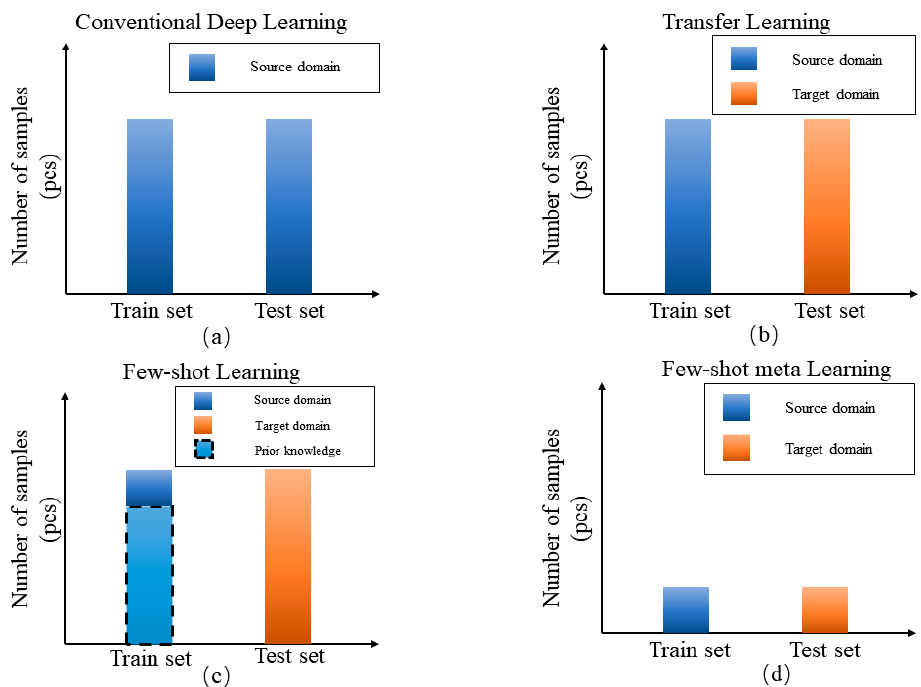
ff erent scenarios for deep learning bearing fault Figure 1. Different scenarios for deep learning bearing fault diagnosis. Figure 1. Di